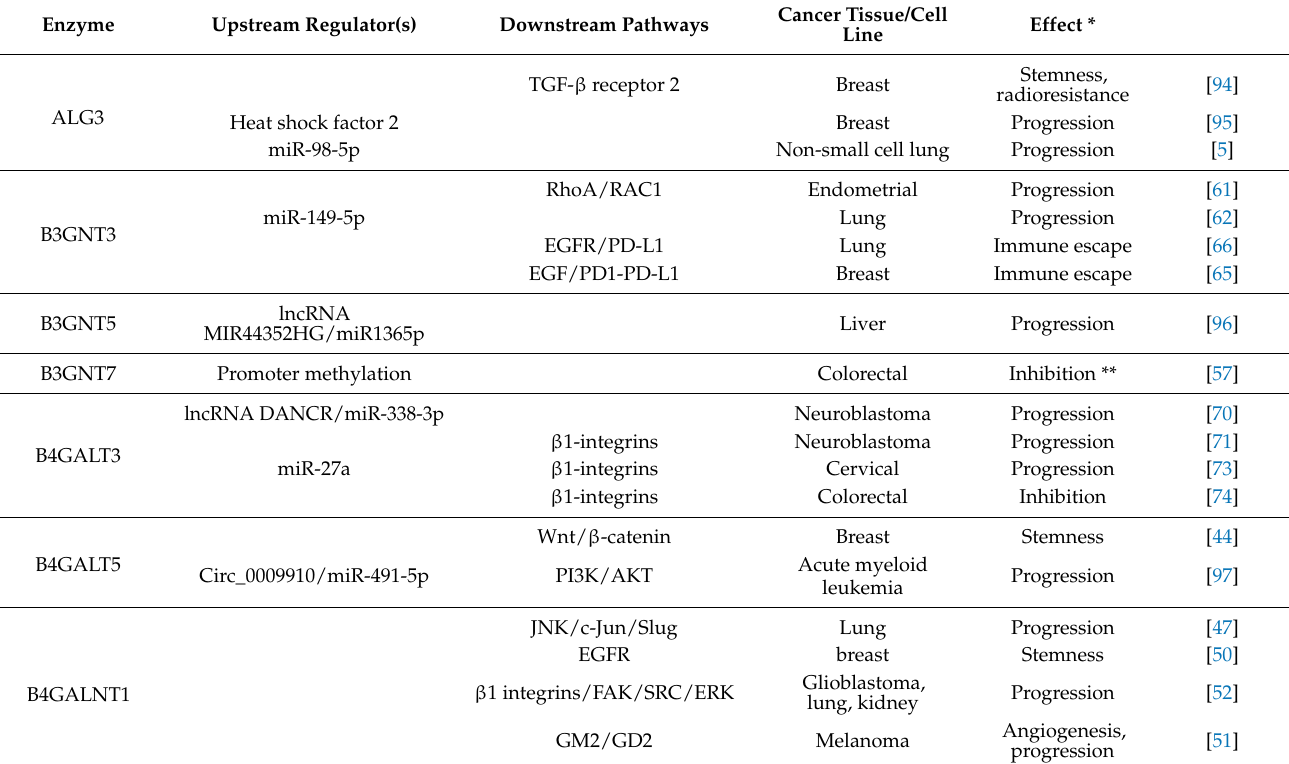
Table 3. Mechanistic aspects of glycosyltransferase action and